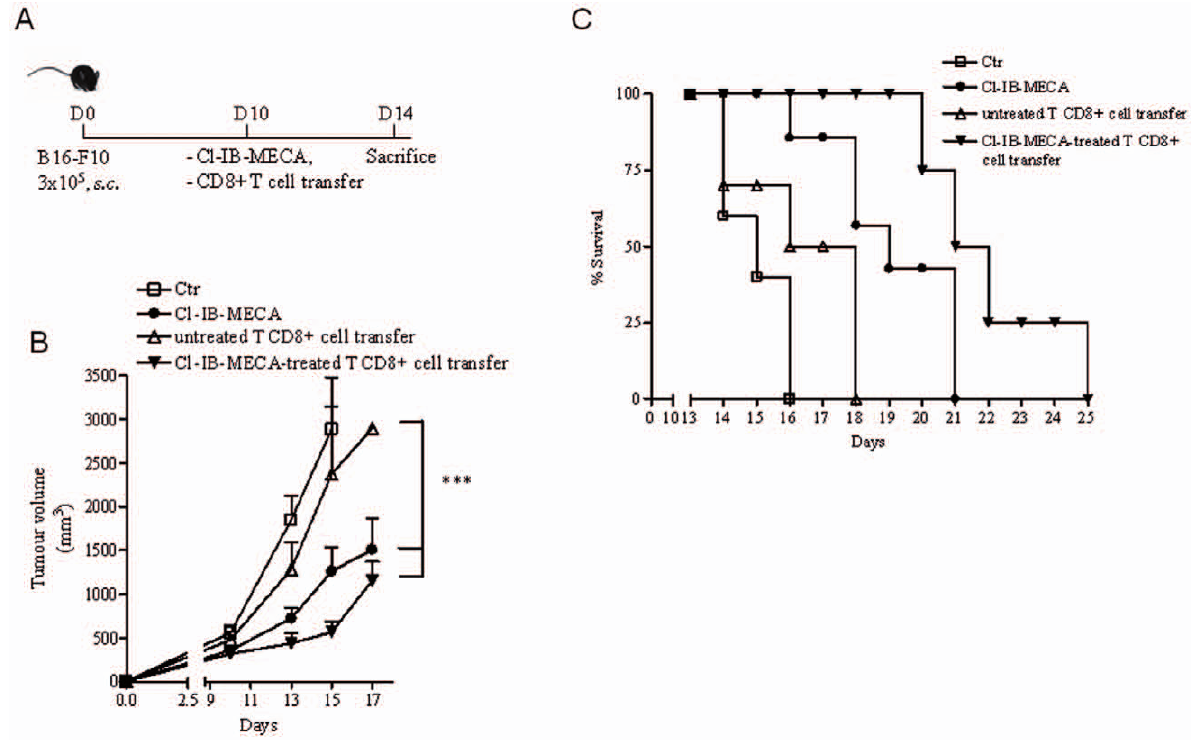
Figure 1. Adoptive transfer of CD8 + T cells cultured with Cl-IB-MECA mediates enhanced tumor suppression in melanoma-bearing mice. A ) C57Bl6j mice were s.c. inoculated with 2.5 6 10 5 cells B16-F10 cells/mouse. 10 days after B16 injection, mice received a single p.t. injection of Cl-IB-MECA (20 ng/mouse) or 1 6 10 6 CD8 + T cells/mouse treated with Cl-IB-MECA (0.1 m g/ml) or 1 6 10 6 untreated CD8 + T cells/mouse or PBS (Ctr). B ) Tumor volume (mm 3 ) measured in control mice (Ctr, n=11) and mice receiving a single dose of Cl-IB-MECA (n=13) or adoptively transferred with Cl- IB-MECA-treated CD8 + T cells (n=14) or with untreated CD8 + T cell (n=10). C ) Increased survival of melanoma-bearing mice receiving Cl-IB-MECA (p , 0.05) or CD8 + T cell transfer cultured with Cl-IB-MECA (p , 0.001) compared with control groups (n=5/group). Data are from three independent experiments and represent mean 6 SEM. Statistical differences were determined by one way ANOVA and Student’s t test, as appropriate. ***p , 0.001. Comparison of survival between groups was performed using long-rank